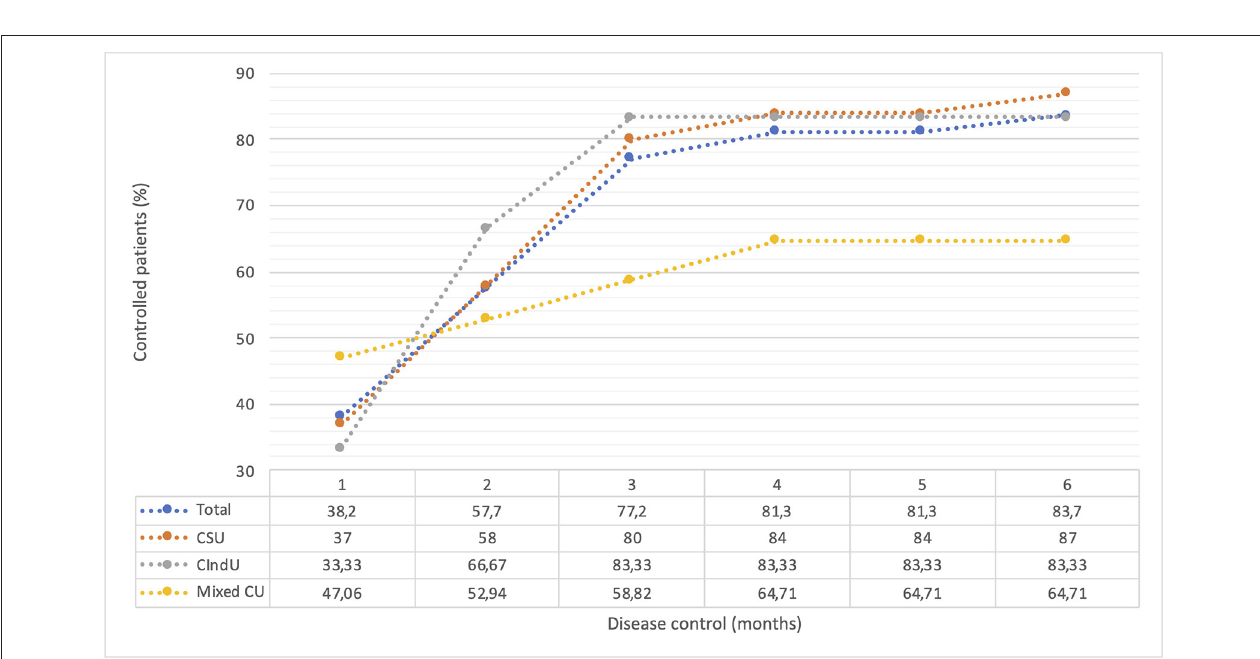
FIGURE 1 | Control of the disease with the use of Omalizumab stratified by type of Chronic Urticaria. Disease control was defined according to the presence of symptoms of urticaria in last 4 weeks of treatment with Omalizumab. Some patients were evaluated using the UCT; those patient with a UCT-score ≥ 12 was considered as “well-controlled disease” (56%; n = 69), while others were evaluated using the clinical interview employing questions comparable to the UCT (57%; n = 70). CU, chronic urticaria; CSU, chronic spontaneous urticaria; CIndU, chronic inducible urticaria; UCT, urticaria control test.